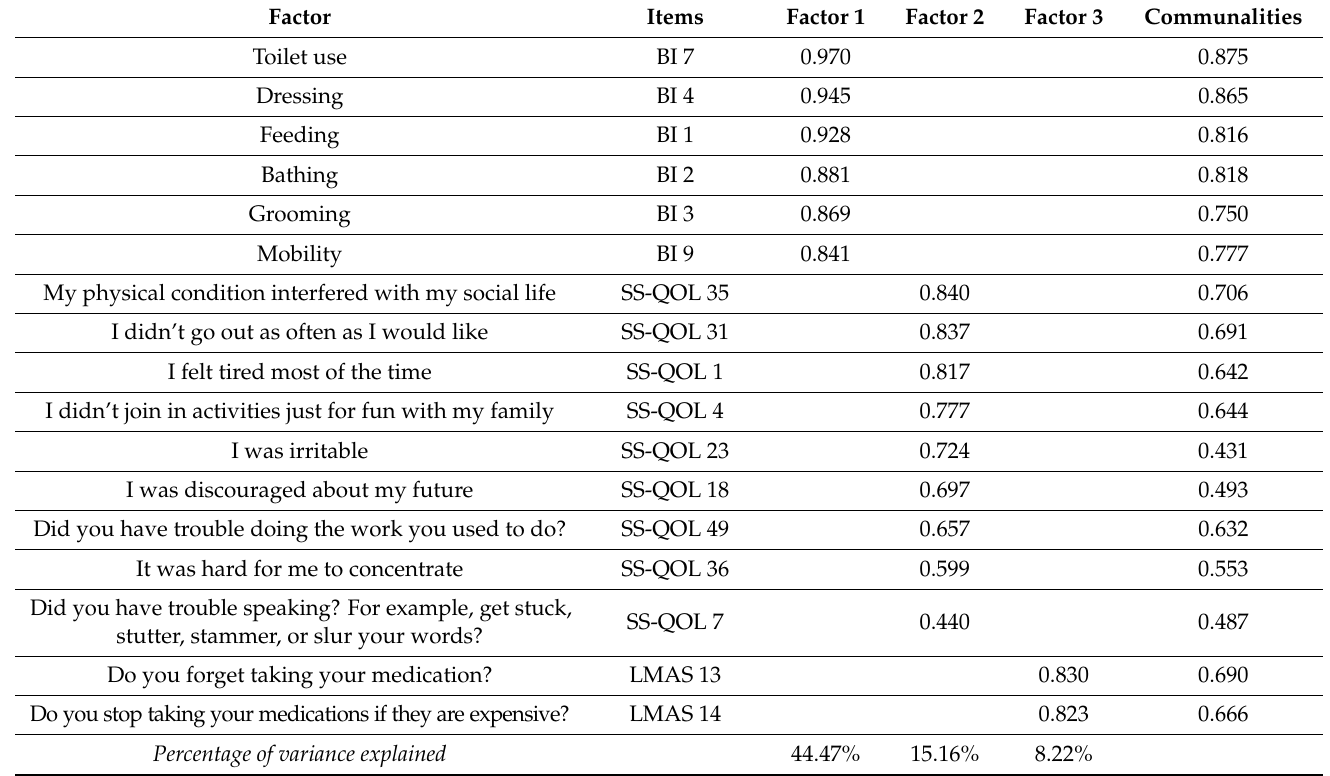
Table 3. Promax-rotated matrix of the